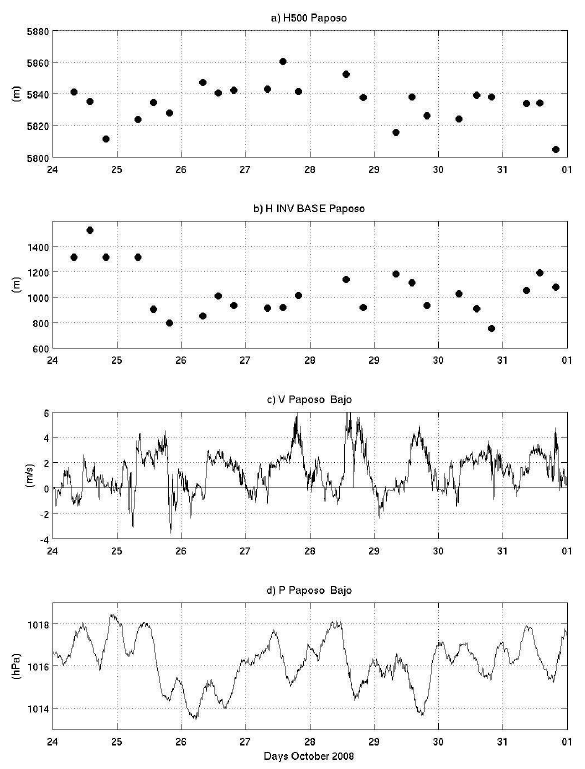
Fig. 12. Time series of (a) 500hPa geopotential height, (b) subsi- dence inversion base, (c) meridional wind speed, (d) atmospheric pressure at Paposo Bajo for the period from 24 to 31 October Figure 12. Time series of a) 500 hPa geopotential height, b) subsidence inversion base, c) 2 meridional wind speed, d) atmospheric pressure at Paposo Bajo for the period from 24 to 31 3 October 2008. 4